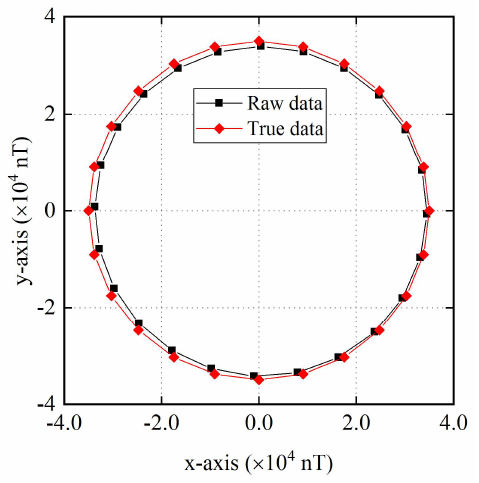
Figure 3. Raw data of the two-axis fluxgate sensor and true data.